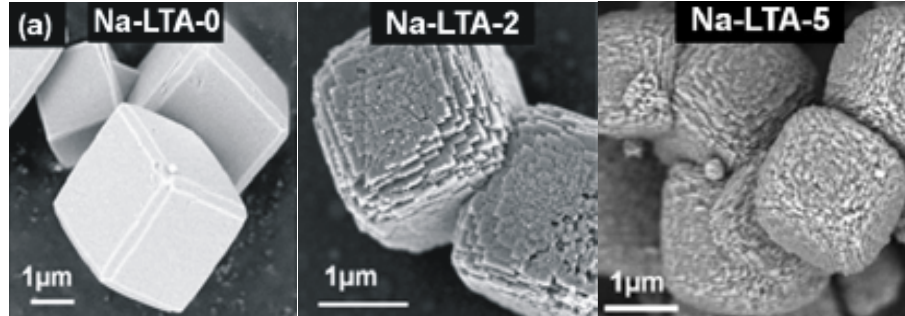
Figure 2. SEM images of crystals of ( a ) the purely microporous zeolite and ( b ) the mesoporous specimens. The images were taken from the external surface of calcined